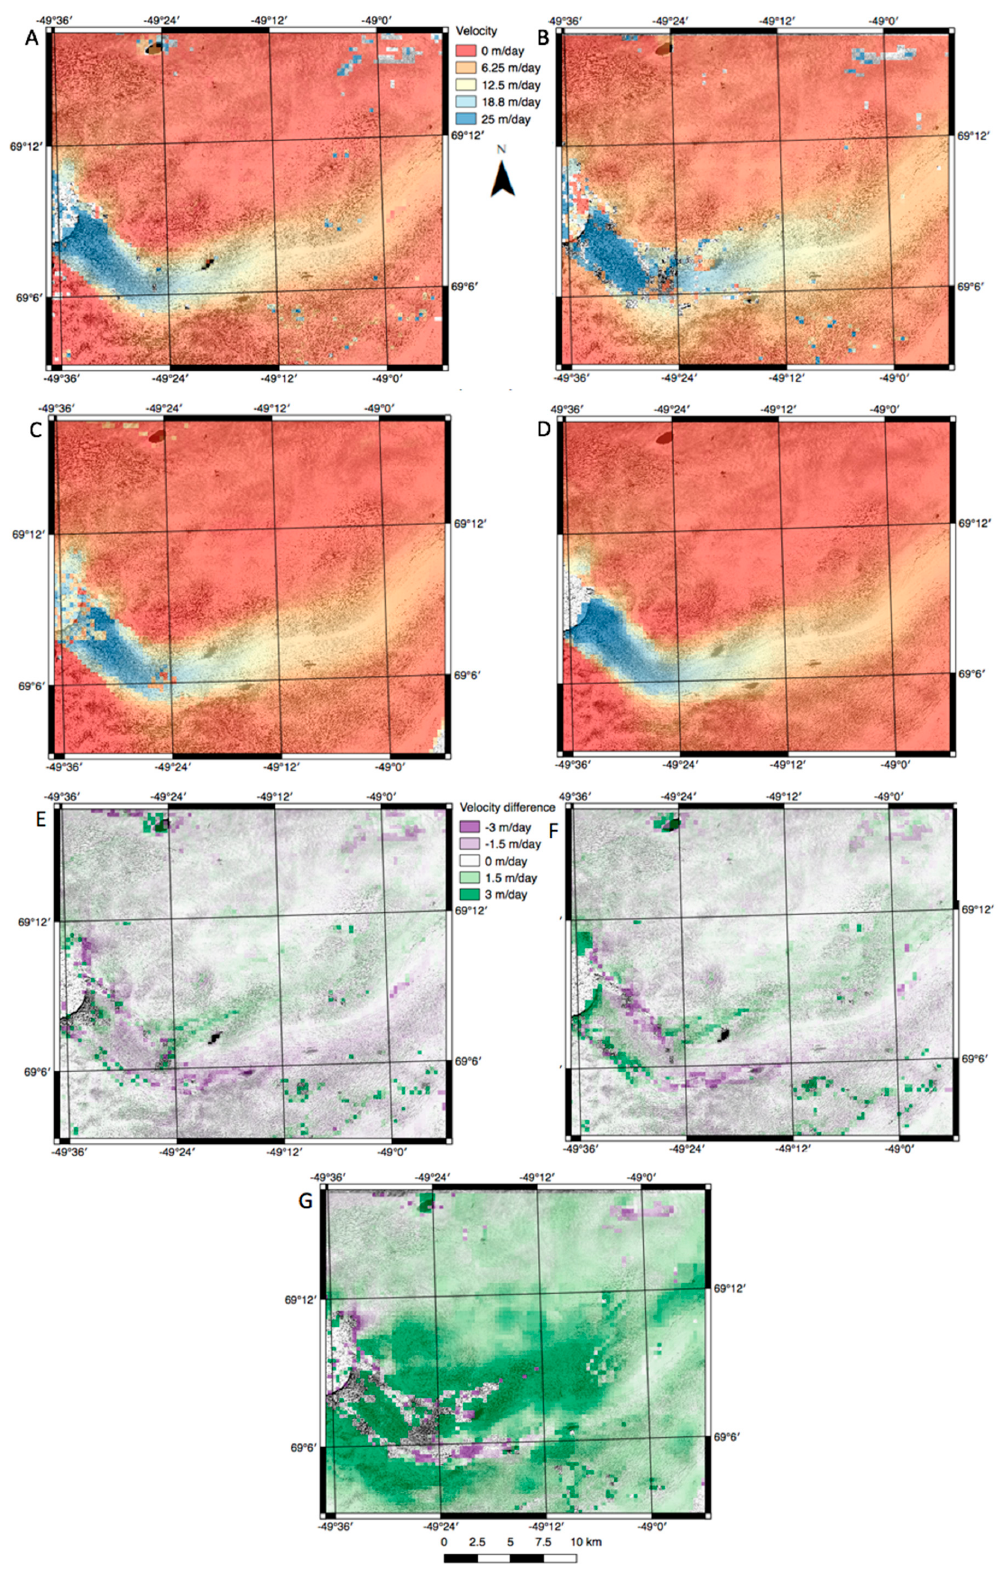
Figure 8. Velocity maps of Jakobshaven Isbræ for: ( A ) pair J3: 18.07.2017–28.07.2018 using SenDiT; ( B ) pair J4: 18.07.2017–03.08.2017 using SenDiT; ( C ) pair J5: 18.07.2017–03.08.2017 using GoLIVE; ( D ) pair J6: 01.07.2017–31.07.2017 using MEaSURE. Velocity di ff erence maps for: ( E ) pairs J3 and J5; ( F ) pairs J3 and J6; ( G ) pairs J4 and